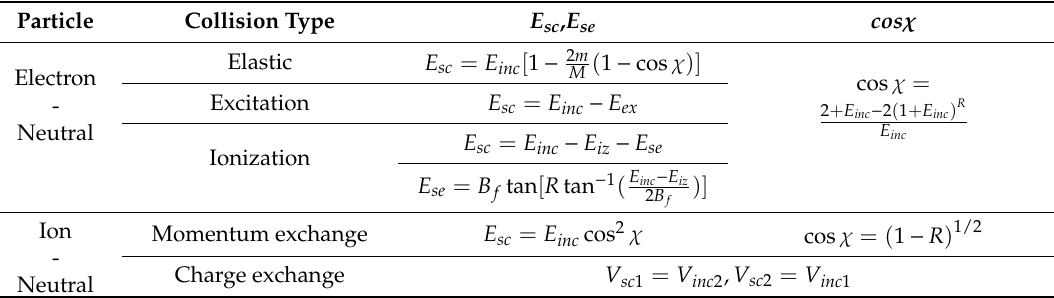
Table 1. Summary of the parameter expressions for new